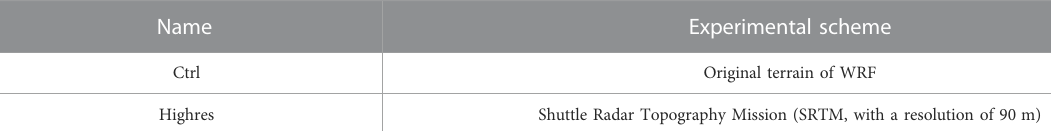
TABLE 1 Experimental schemes for terrains with different resolutions.